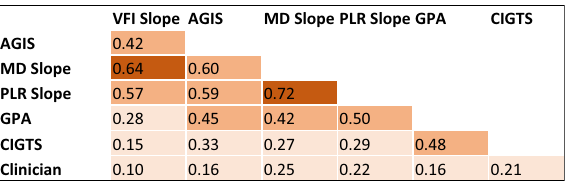
Table 2. Kappa coefficients to assess agreement across methods to define VF worsening. The level of agreement is highlighted by the color in the table with a darker shade indicating greater agreement.